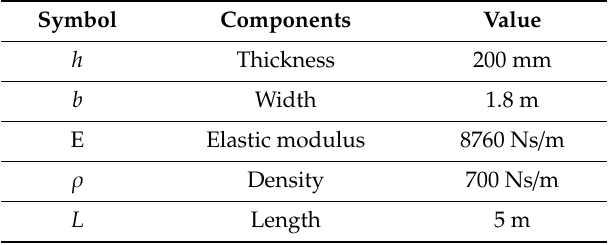
Table 2. Euler–Bernoulli beam